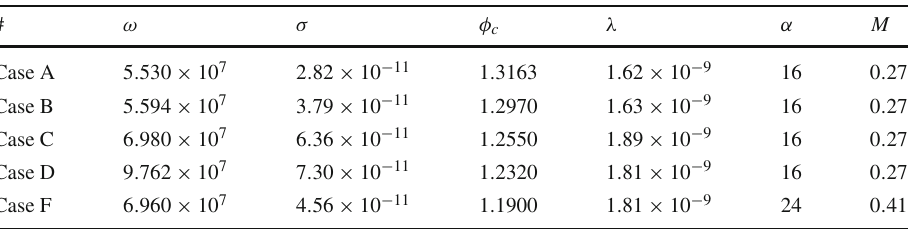
Table 2 The attained outcomes for the Cases of Table 1. The climax values of the scalar power spectrum and fractional abundance of PBHs are given by peak P peak , respectively. s and f PBH M peak is the PBH PBH